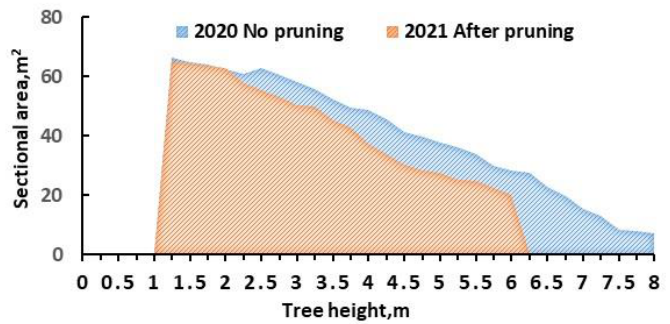
Figure 12. Sectional area of vegetation in a mature tree at different heights.